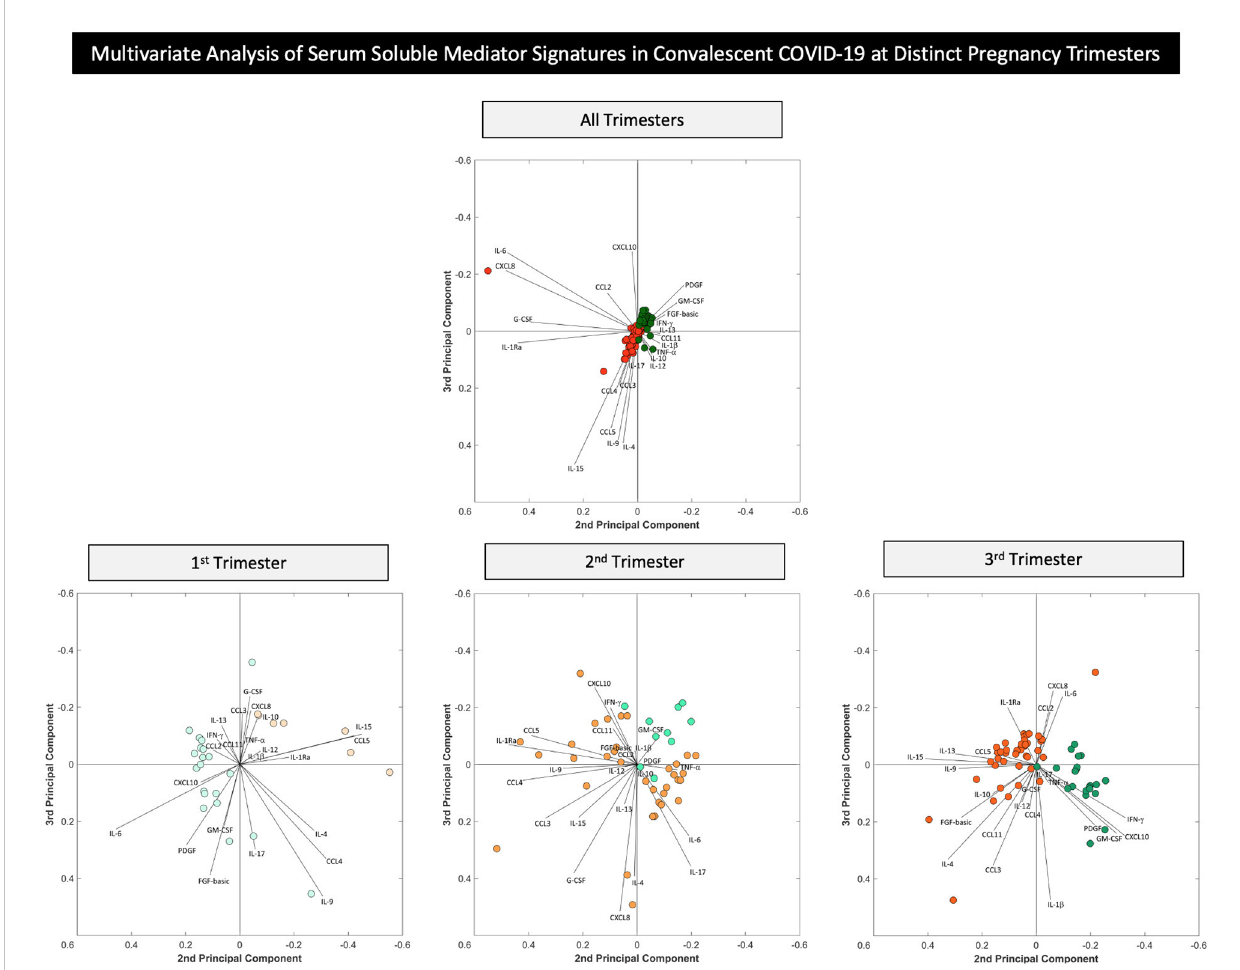
FIGURE 6 Multivariate analysis of serum soluble mediator networks in convalescent COVID-19 patients at distinct pregnancy trimesters. Multivariate analysis of serum chemokines, pro-in fl ammatory cytokines, regulatory cytokines and growth factors were performed to verify the ability of soluble mediators to cluster convalescent COVID-19 pregnant women at 3-20 weeks after symptoms onset (COVID, n=89), with pre-pandemic non-infected pregnant women as a Healthy Control (HC, n=52) as well as subgroups of COVID-19 and HC categorized according to pregnancy trimester, referred to as: HC 1 st ( , n=21), HC 2 nd ( , n=10), HC 3 rd ( , n=21) and COVID 1 st ( , n=7), COVID 2 nd ( , n=34), COVID 3 rd ( , n=48). The measurements were taken by high-throughput multiplex bead array as described in Material and Methods. Principal Component Analysis (PCA) was carried out by MATLAB software as described in Material and Methods. PCA coordinates (2 nd and 3 rd principal components) were used to compare and visualize the grouping of convalescent COVID-19 vs HC and subgroups according to pregnancy